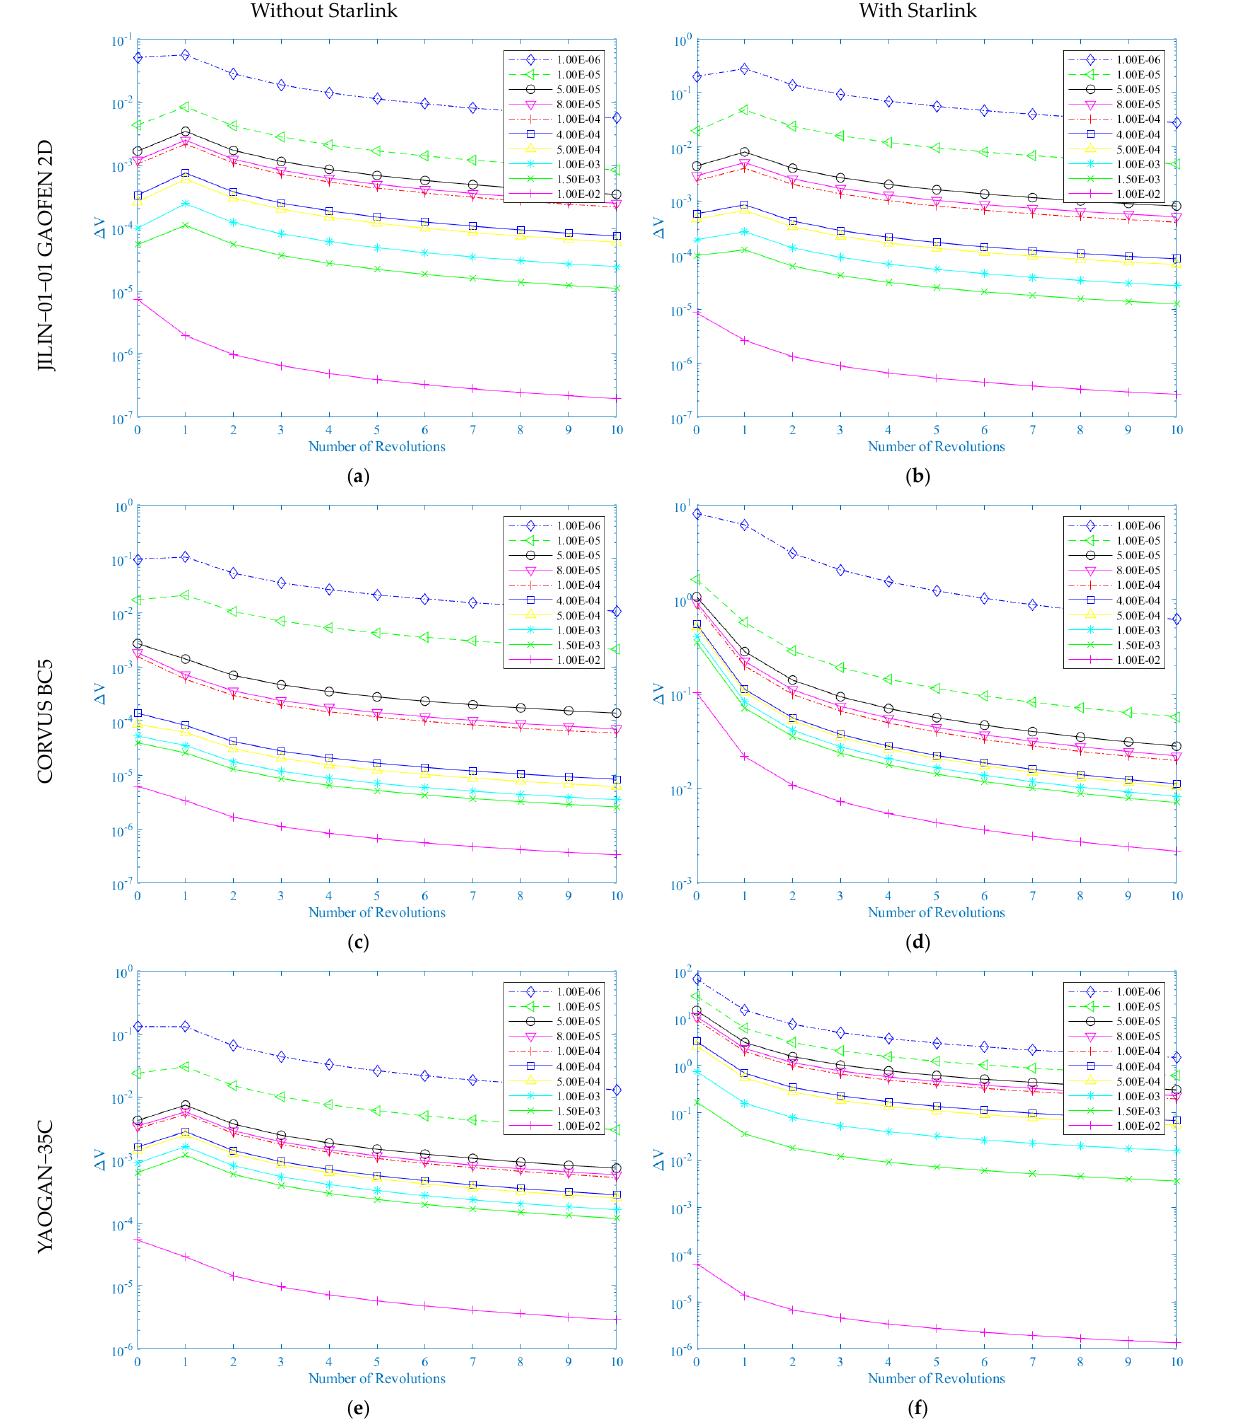
Figure 9. Required for different ACPL values in ten revolutions to change track ∆ V .( a , b ) Comparison of different ∆ V variations with and without Starlink for GAOFEN; ( c , d ) Comparison of different ∆ V variations with and without Starlink for CORVUS BC5; ( e , f ) Comparison of different ∆ V variations with and without Starlink for YAOGAN − .